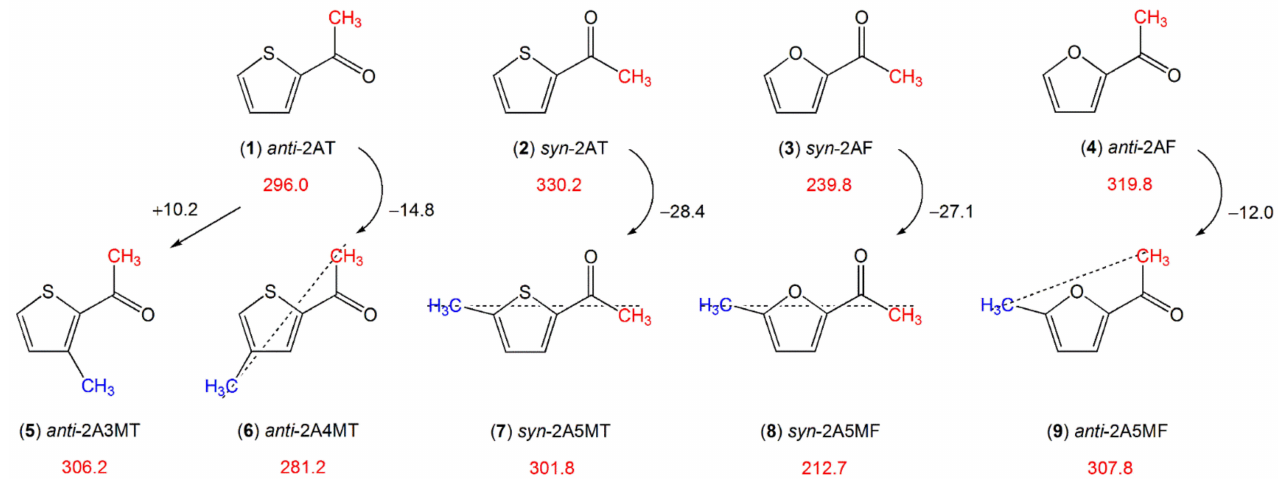
Figure 12. Barriers to methyl internal rotation in furan and thiophene derivatives with an acetyl-group-containing substituent (in cm − 1